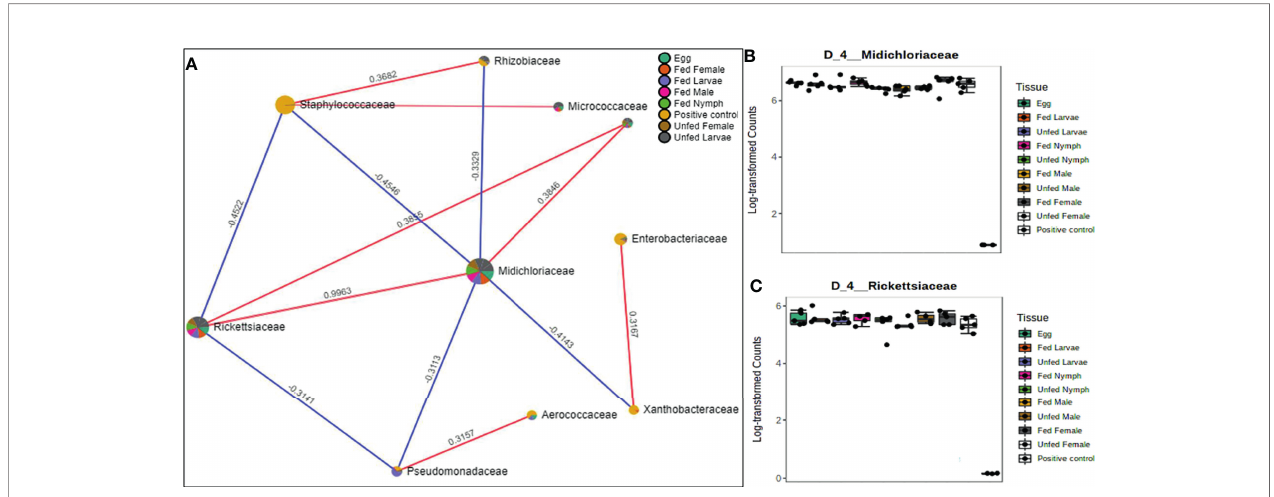
FIGURE 6 | Correlation network analysis in different life stages of laboratory-raised Amblyomma americanum ticks. Correlation network generated using the SparCC algorithm. Correlation network with nodes representing taxa at the family level and edges representing correlations between taxa pairs (A) and representative box plots showing enriched abundance of Midichloriaceae (B) , and Rickettsiaceae (C) across all